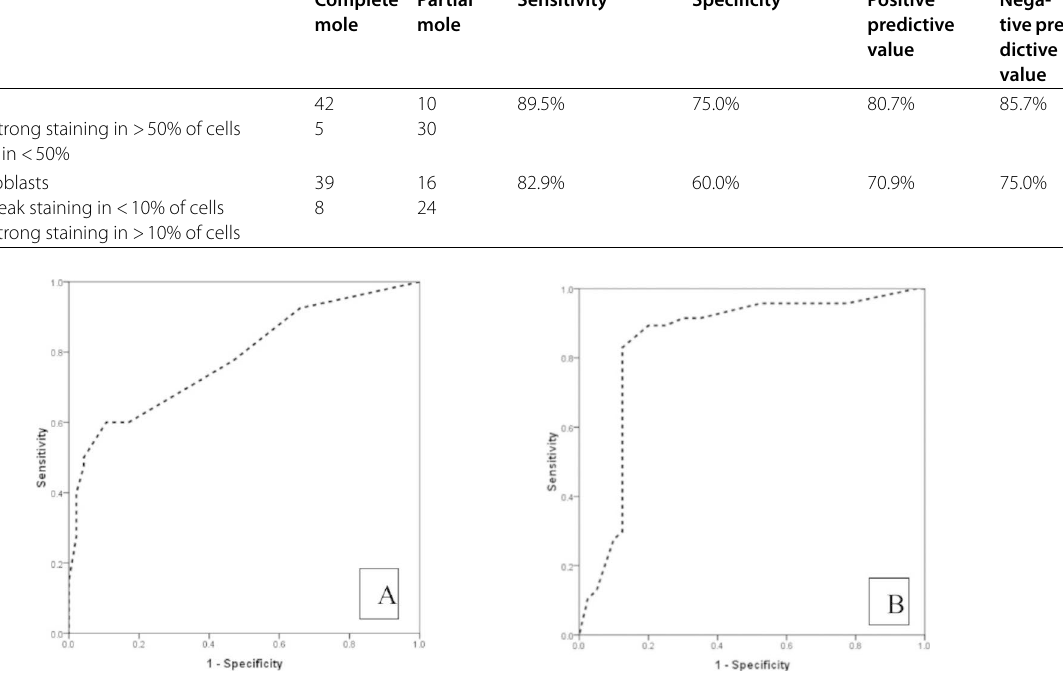
Nega- predictive tive pre- value dictive value